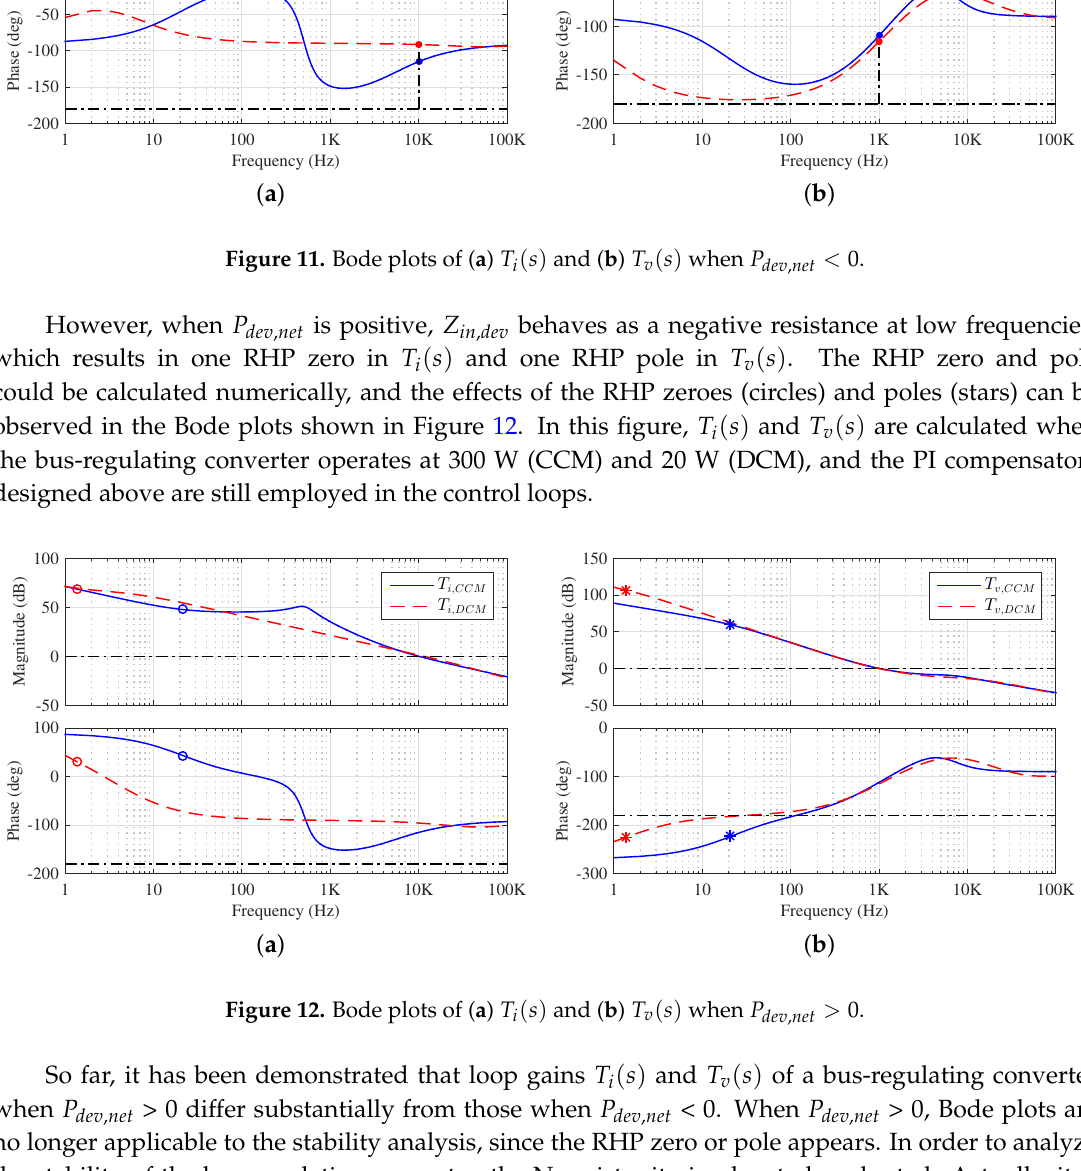
Figure 12. Bode plots of ( a ) T i ( s ) and ( b ) T v ( s ) when P dev , net >